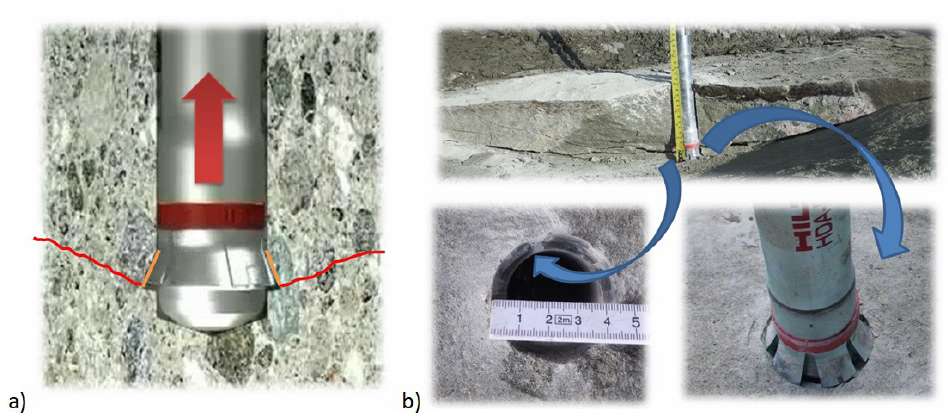
Figure 6: Loosening process with use of an undercutting anchor: a) line of crack propagation, b) fixation